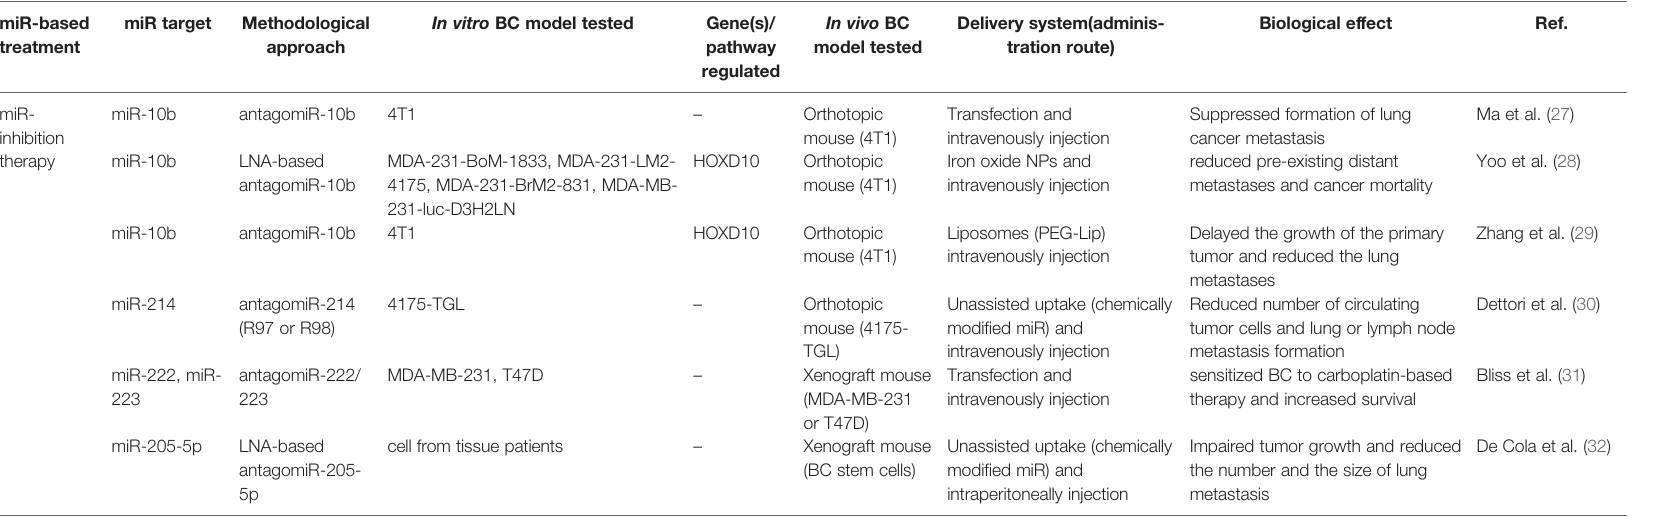
TABLE 2 | miR-based therapy and their role as antimetastatic drugs in BC treatment. miR-based